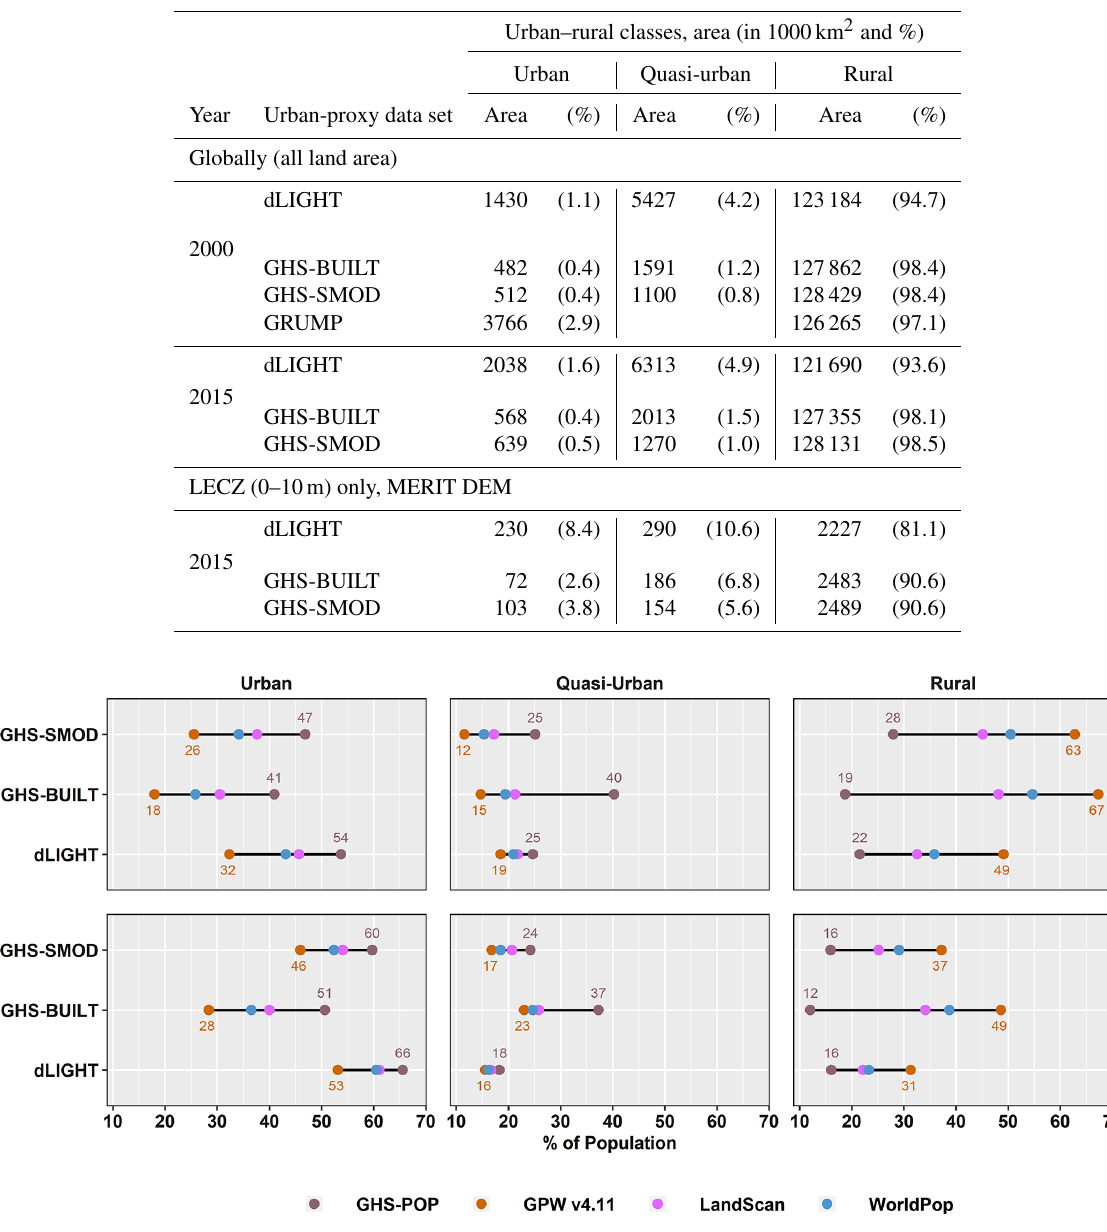
Figure 11. Percent of total population, by urban–rural classes, using different urban-proxy and population data sources, globally and in the ≤ 10m LECZ (using MERIT DEM)